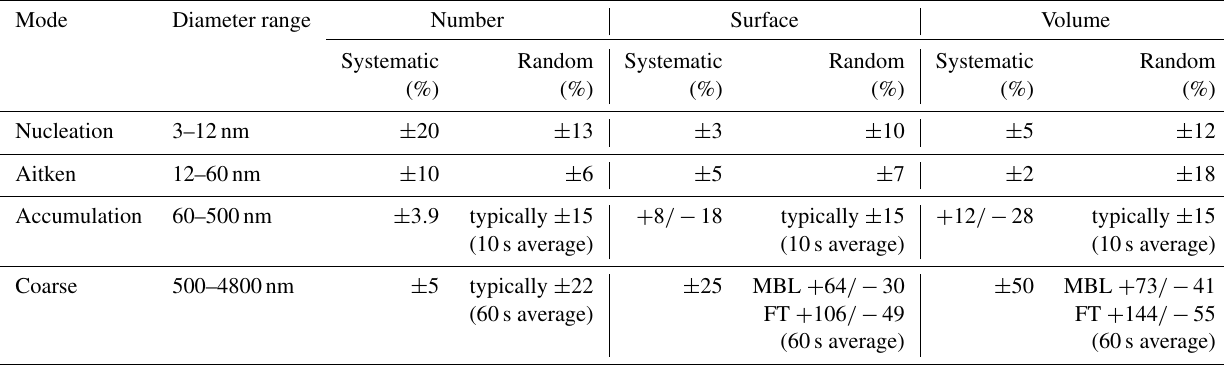
Table 1. Estimated systematic and random uncertainties. Mode Diameter range Number Surface Volume Systematic Random Systematic Random Systematic